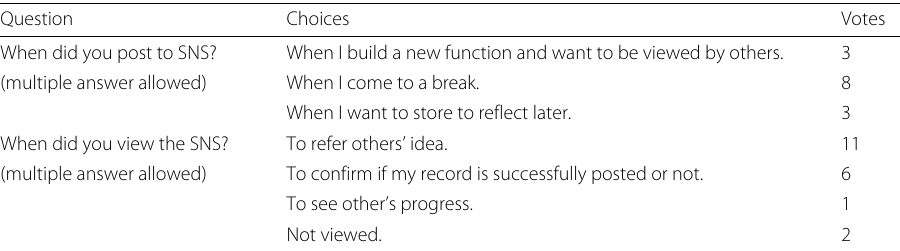
Table 5 Questions on when to use the SNS Question Choices Votes When did you post to